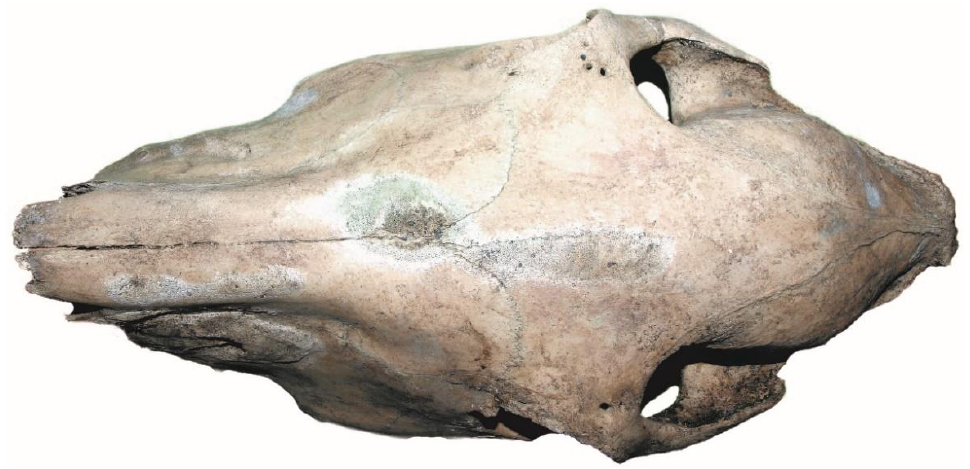
Figure 6. Gdańsk, Sukiennicza street (site 1). A horse's skull with traces of a past bacterial disease Figure 6. Gda´nsk, Sukiennicza street (site 1). A horse’s skull with traces of a past bacterial disease (photo by D. Makowiecki). (photo by D.